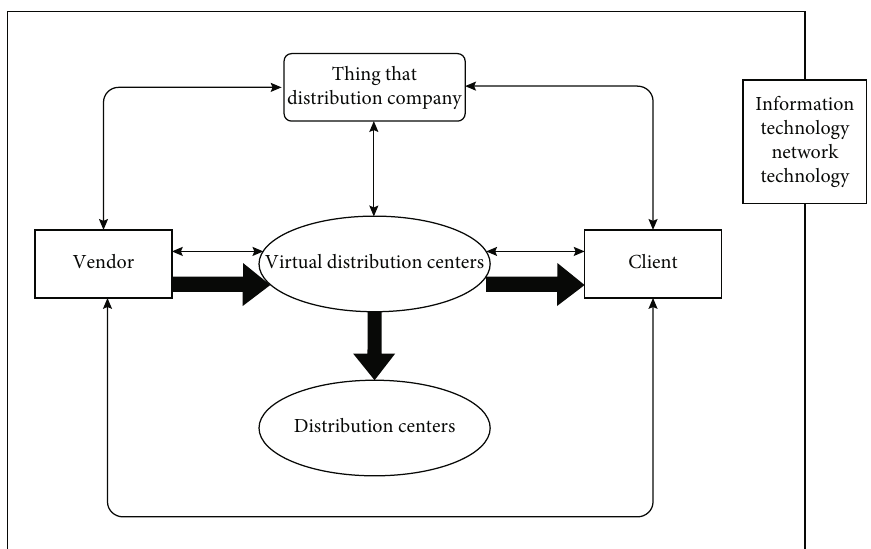
Figure 1: Virtual logistics delivering